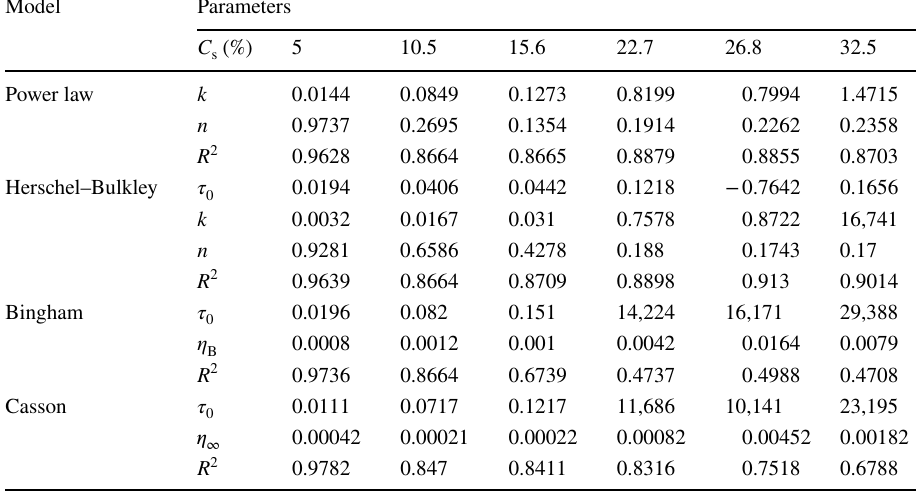
Table 3 Parameters of different rheological models with different solids concentrations and coefficient of